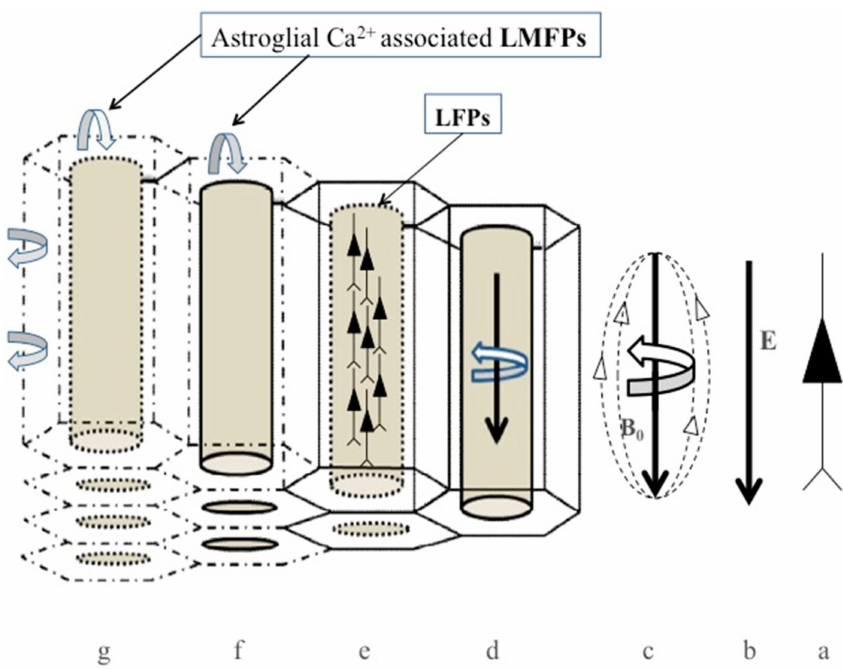
Figure 3. Schematic representation of the bioelectromagnetic field distribution in the neocortex and gliocortex. Schematic representation of a pyramidal neuron of the cerebral cortex ( a ). Bioelectric (E) and biomagnetic (B 0 ) fields generated following the dendritic–axonal direction ( b and c , respectively). Cylinders represent neuronal minicolumns, and hexagons represent the astroglial matrix ( d – g ). Bioelectromagnetic fields associated with neuronal activities in minicolumns ( d ), which modulate local field potentials (LFPs) ( e ). Ca 2 + -associated bioelectromagnetic fields can modulate LMFPs ( f ). Neuron–astroglial biomagnetic crosstalk ( g